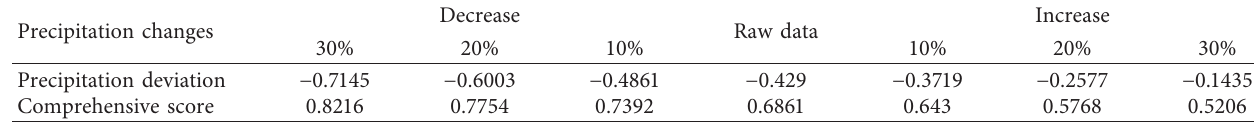
Table 7: Impact of precipitation on vulnerability.